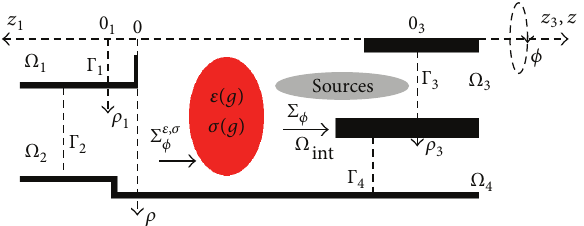
Figure 1: Open axially symmetrical waveguide transformer.